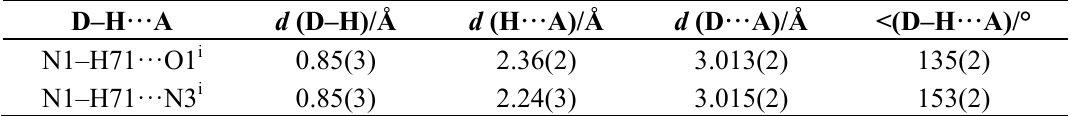
Table 2. Distances and angles of the hydrogen bonds of 1